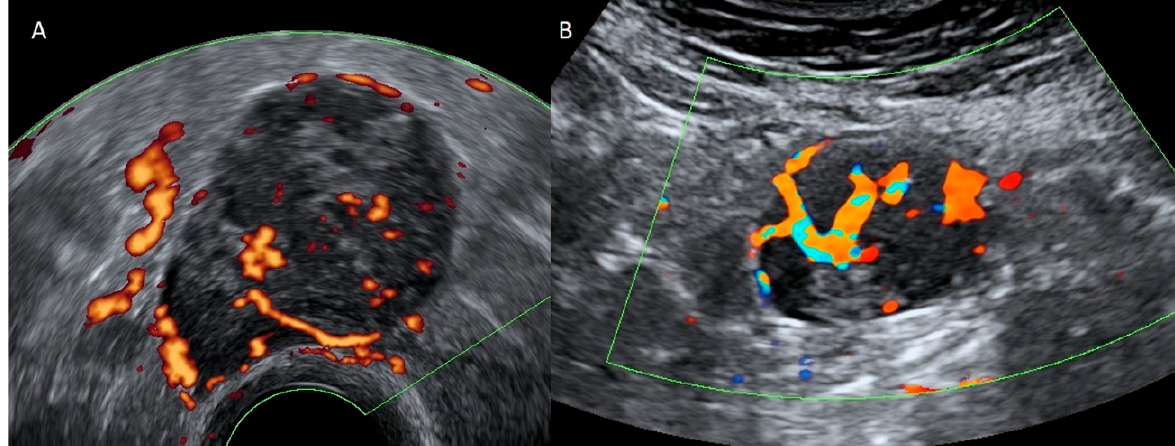
Figure 11. Power Doppler transvaginal ultrasound ( A ) and color Doppler transabdominal ultrasound ( B ) demonstrate abundant vascularization inside the GIST.